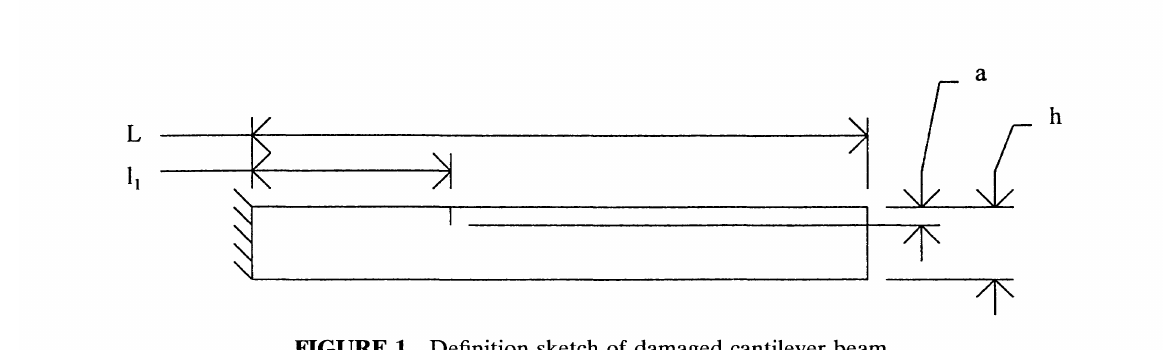
FIGURE 1 Definition sketch of damaged cantilever